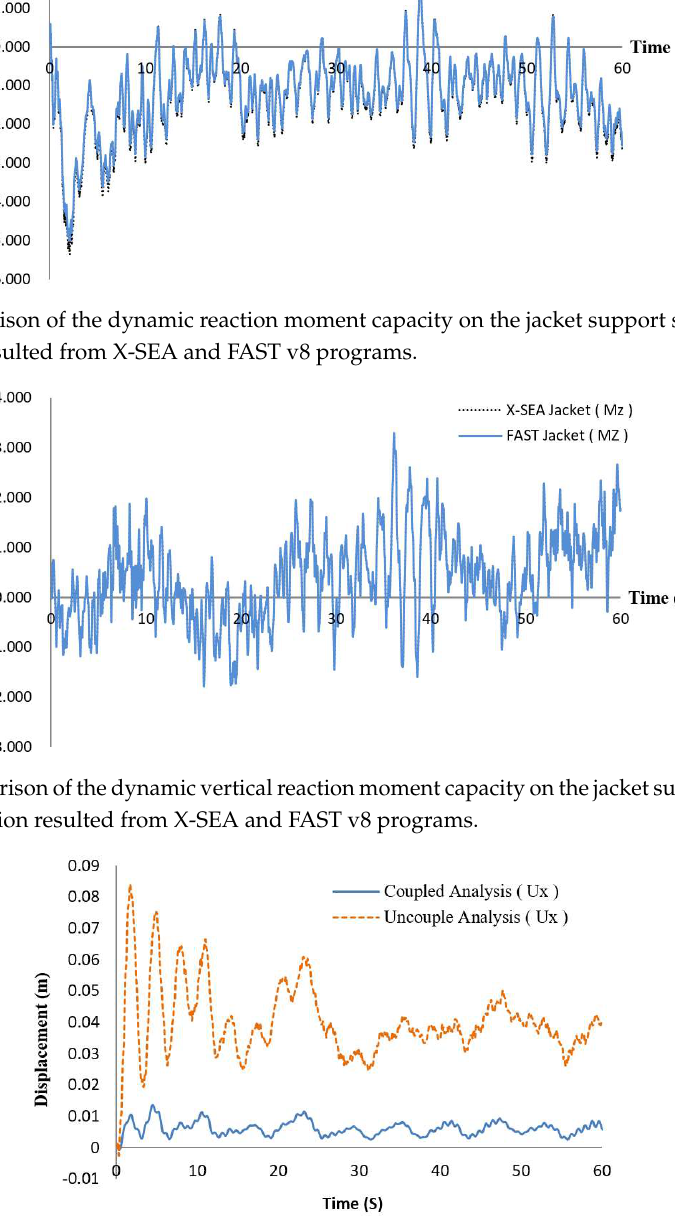
Figure 12. Comparison of displacement in the y-direction resulted from coupled and uncoupled analyses from the X-SEA program. The X-SEA program was used to determine the hydrodynamic forces and calculate the responses of the substructure by interchanging the displacement, velocity, acceleration, force and moment at the interface point with the FAST v8 program. Between these two programs, these responses were exchanged using the present study module. The displacement of the coupled and uncoupled analysis method was monitored below the interface joint for obtaining the accurate responses of the structure in x- and y-directions as shown in Figures 11 and 12. It is obvious from these plots that, in the coupled analysis the interaction between the support structure and the tower structure was accounted for, the averaged oscillation of the structure was therefore 6.9 times less than that of the uncoupled analysis. In addition, the coupled analysis of the turbine and structure produced a result close to the realistic behavior of a wind turbine in the test site, which includes the turbine effect while the computational time was only slightly different. 3.3. Dynamic Coupled Analysis of Turbine and Support Structure-Pile-Soil Interaction In this example, the coupled analysis of a NREL 5MW offshore wind turbine, jacket support structure and structure-pile-soil interaction was performed. The geometry and section properties of the jacket structure were mentioned in the above section. In this case, the pile head was connected with four cylindrical tubes of 55 m depth, 1.5 m diameter and 0.05 m thickness and penetrated the